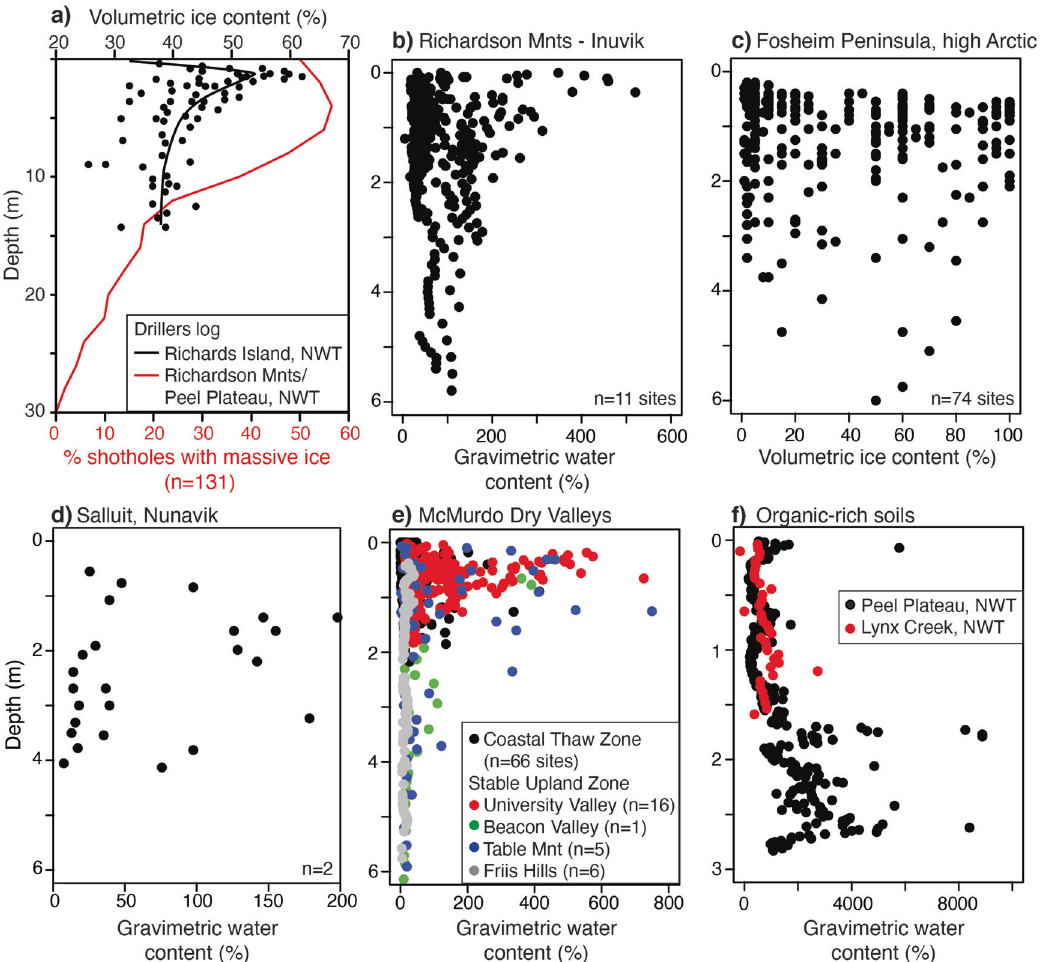
Fig. 2 Vertical distribution of ground ice at hundreds of sites in Arctic Canada and McMurdo Dry Valleys, Antarctica. a Ground ice abundance derived from seismic shotholes in western Arctic Canada (low Arctic). b Gravimetric water content from 11 sites in the Richardson Mountains and Inuvik region (low Arctic). c Gravimetric water content from 74 sites in the Fosheim Peninsula region (high Arctic). d Gravimetric water content from 2 sites in Northern Quebec (low Arctic). e Gravimetric water content from 94 sites in the McMurdo Dry Valleys of Antarctica. f Gravimetric water content from 2 sites with organic-rich soils. See Fig. 1 for locations of sites and methods for source of